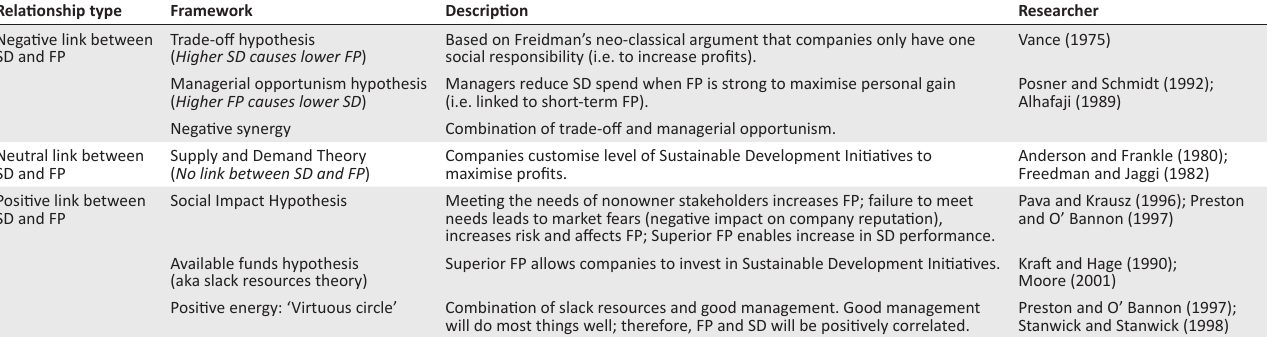
TABLE 2: Frameworks, hypotheses and descriptions of prior research to test the relationship between sustainable development and financial performance. Relationship type